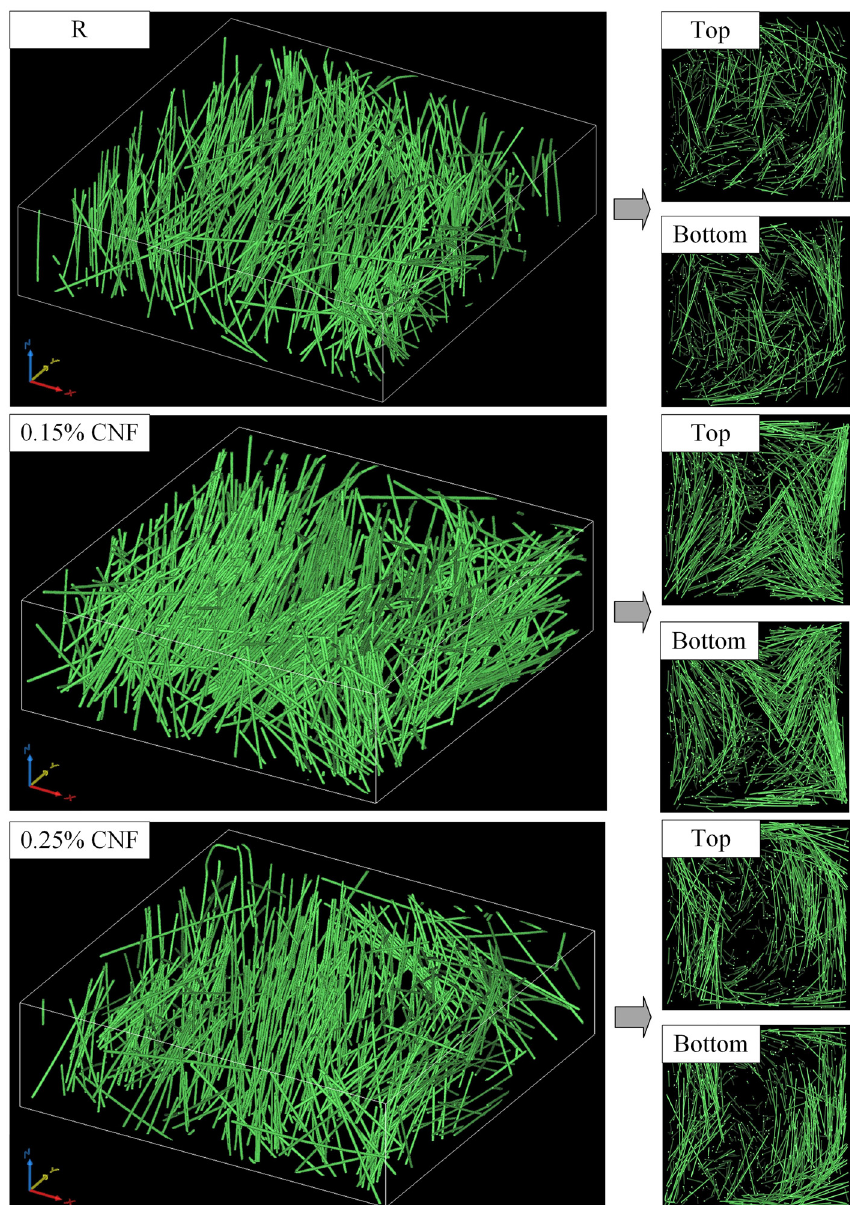
Figure 11: Steel fi bers spatial distribution of UHPC specimens with various matrix rheology. The distribution density of steel fi bers at the bottom of specimens decreased with the increase in CNF